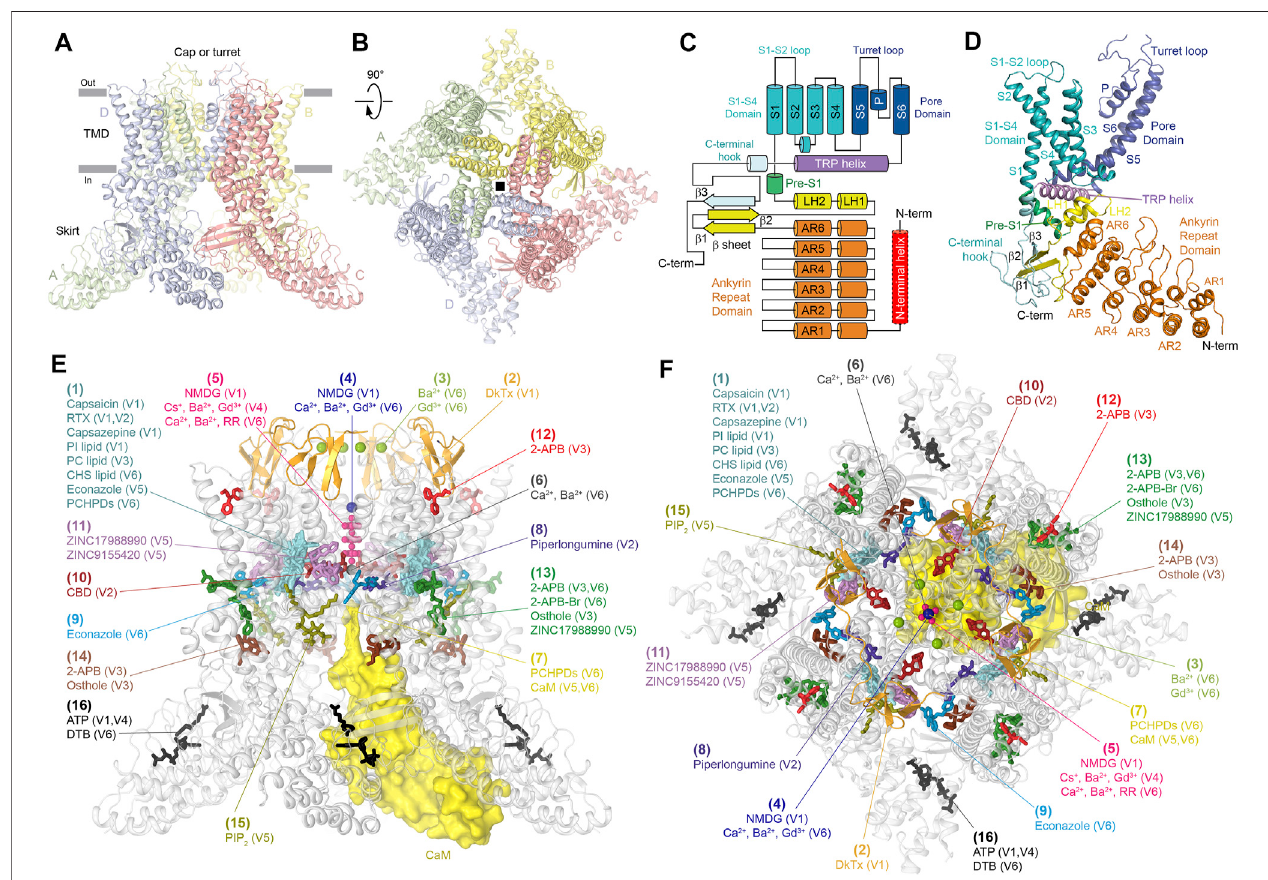
FIGURE 1 | Vanilloid-subfamily TRP channel architecture and mapping of binding sites. (A – B) Side (A) and top (B) views of the TRPV1 tetramer (PDB ID: 7LQY) with each subunit shown in a different color. (C) Domain organization diagram of TRPV subunit. The N-terminal helix (red) is only present in TRPV5 and TRPV6. (D) Structure of the TRPV1 subunit with domains colored as in (C) . (E) – (F) Side (E) and top (F) views of the TRPV1 tetramer (gray) with 16 unique binding sites mapped by differently colored ligands.